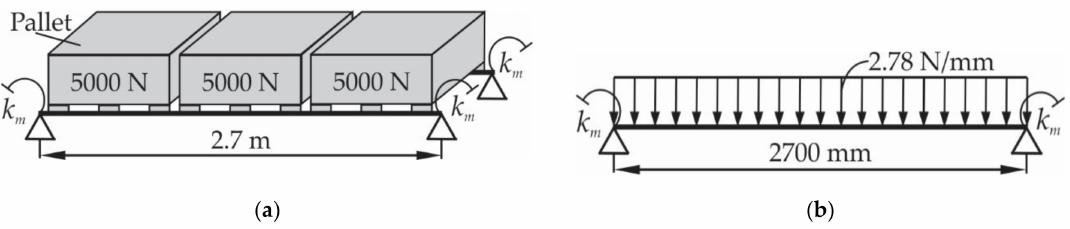
Figure 19. Scheme of loading: ( a ) loading for two beams, and ( b ) equivalent scheme of loading for calculus (k m represents the rotational sti ff ness of the